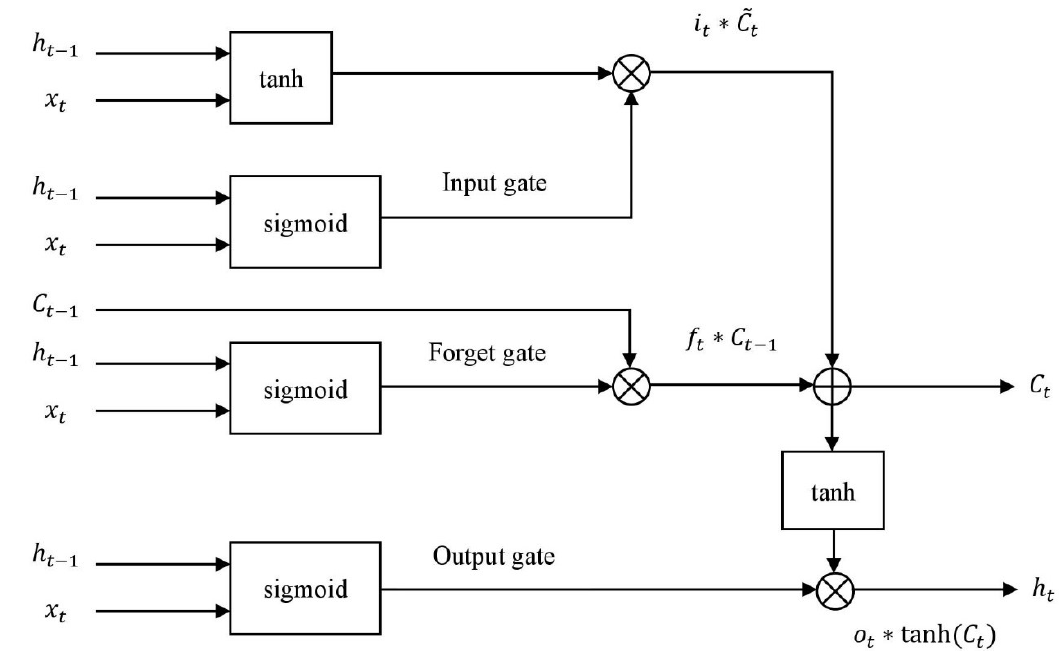
Figure 1. The basic structure of a long short-term memory (LSTM) block.